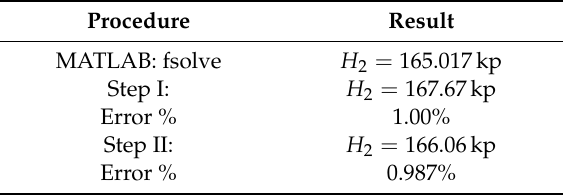
Table 6. Results for the cable RZ 3x95 Al / 54.6 Alm